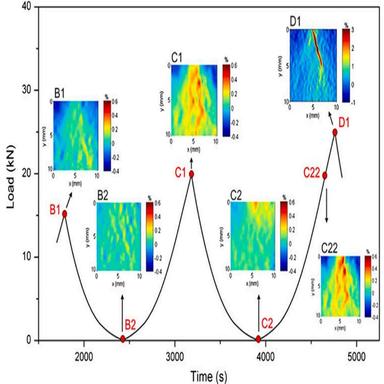
Evolution of strain localization and the crack propagation during reloading and unloading process. The copyright permission for this figure has been granted.